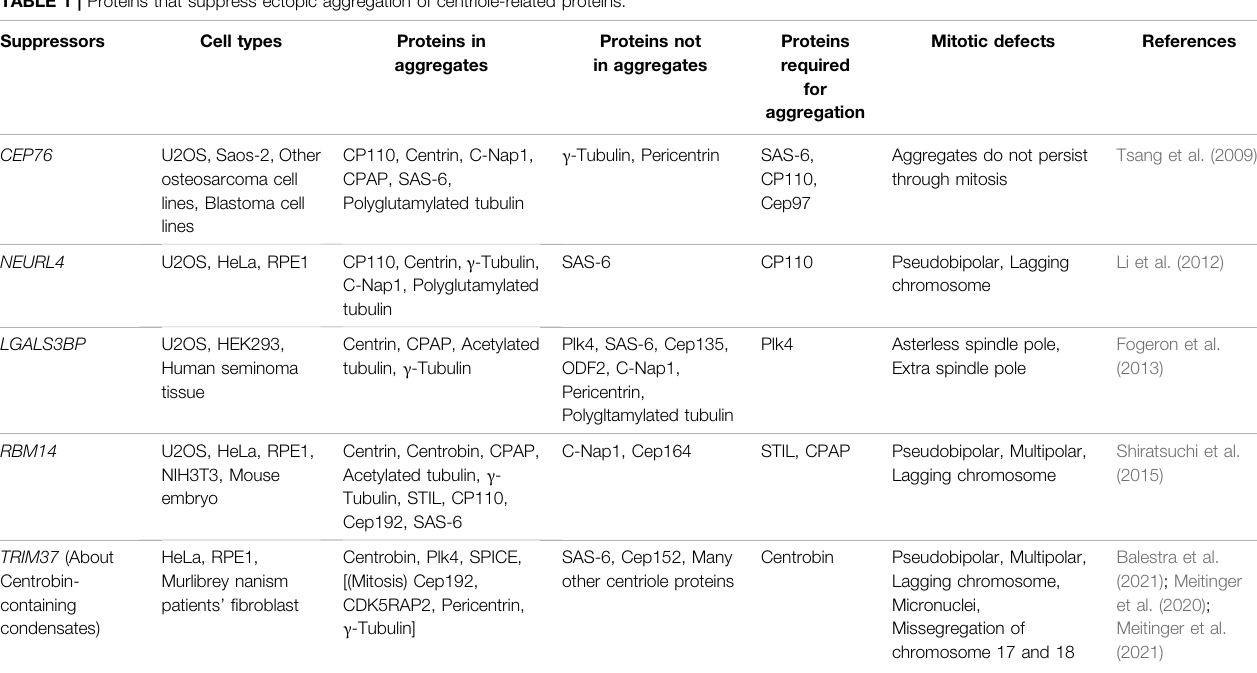
TABLE 1 | Proteins that suppress ectopic aggregation of centriole-related